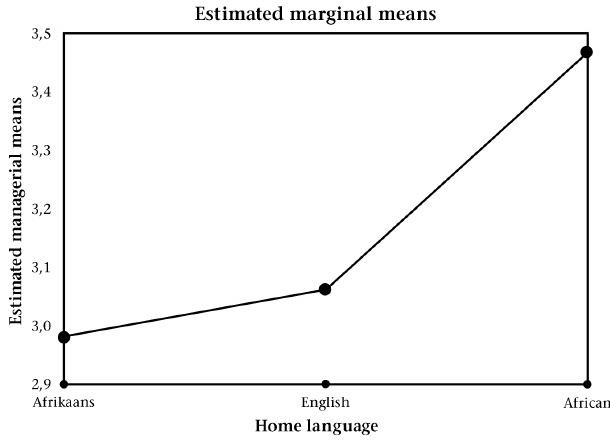
Figure 7: Biographical variable: Home language as predictor of the perceptions of black economic empowerment